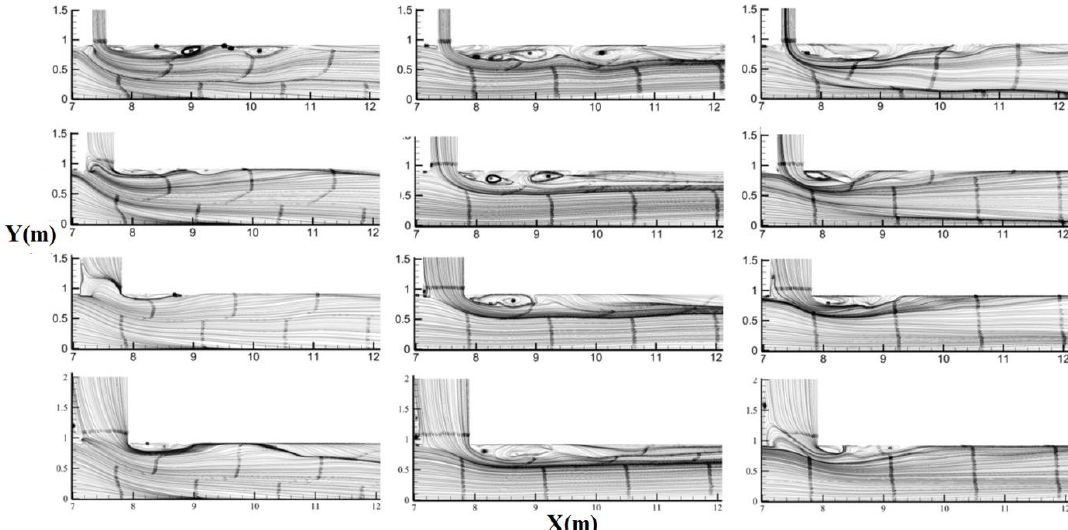
Figure 6. The effect of changing W* on the flow pattern at different elevations for various cases.